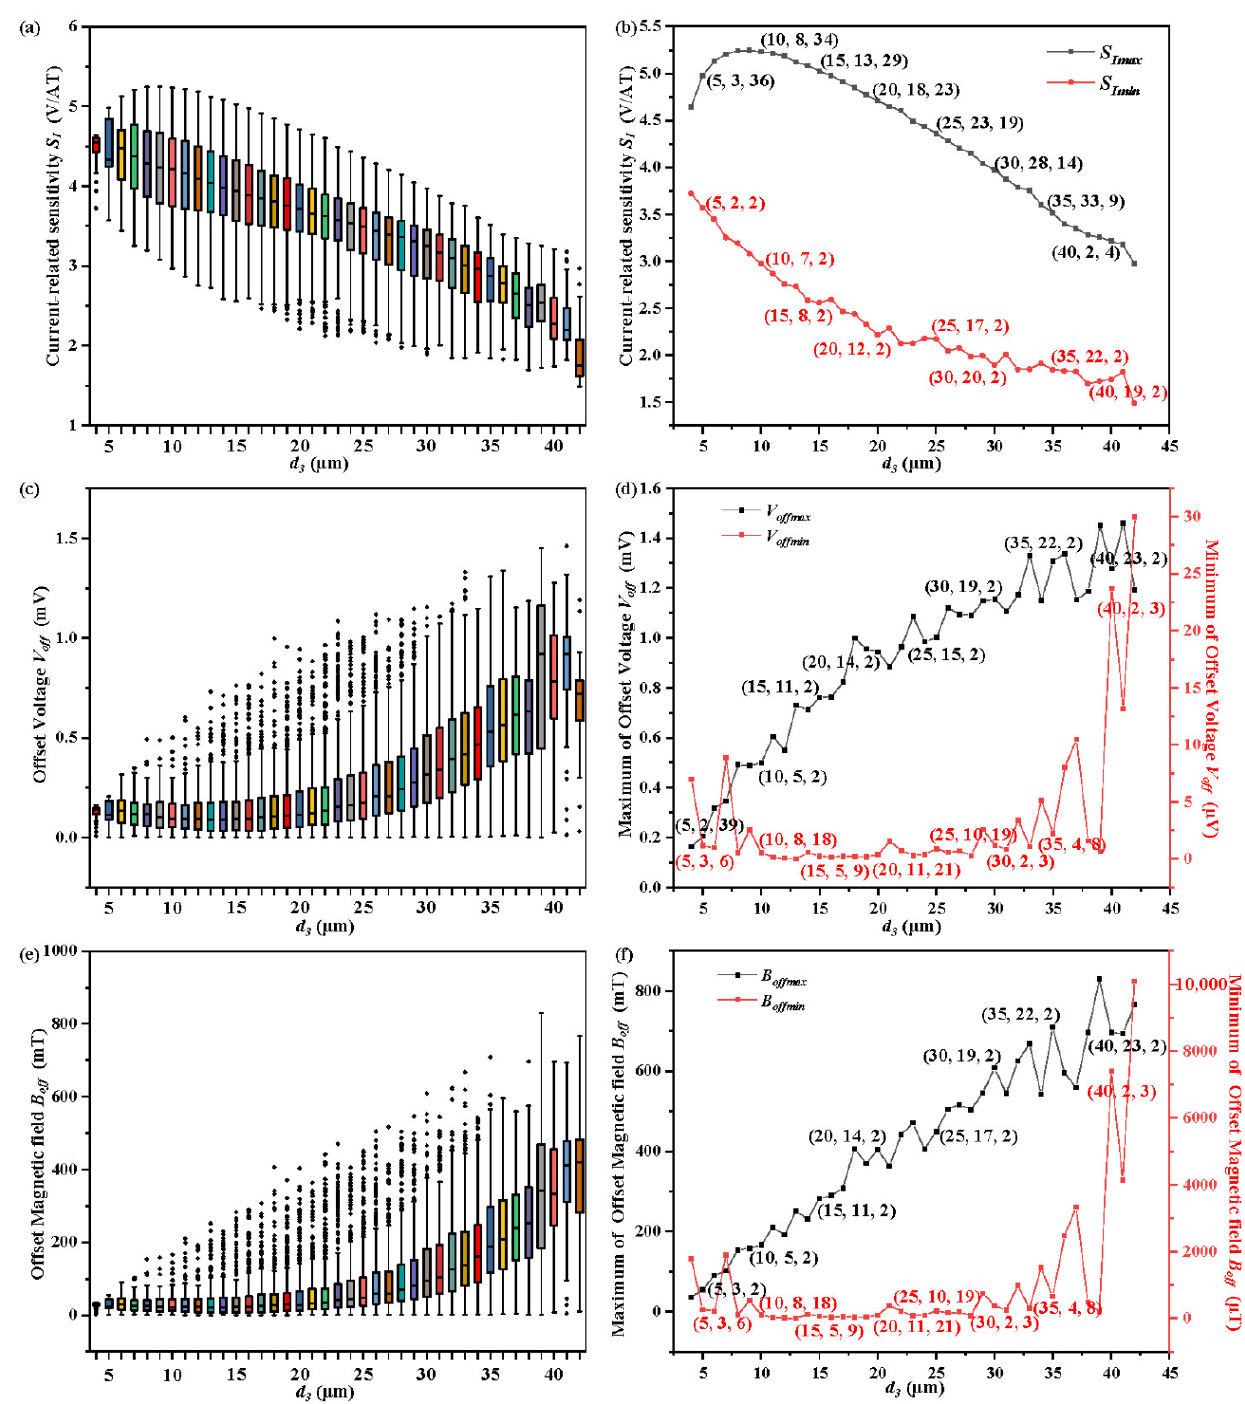
Figure 6. Current-related sensitivity S I ( a ), offset voltage V off ( c ), and offset magnetic field B off ( e ) of d 3 from 4 to 42 µ m with the length l set to 90 µ m illustrated by boxplots. Maximum and minimum values of current-related sensitivity S Imax and S Imin ( b ), offset voltage V offmax and V offmin ( d ), and offset magnetic field B offmax and B offmin ( f ) in d 3 from 4 to 42 µ m extracted from ( a , c , d ), respectively. To focus on the impacts of d 3 on S I , V off and B off , we fix the distances of C3 to C4, C4 to C5, C1 to the left boundary, and C7 to the right boundary. In addition, the length of the 7CVHS is always set as 90 µ m. Then, the value of d 3 varies from 4 µ m to 40.5 µ m